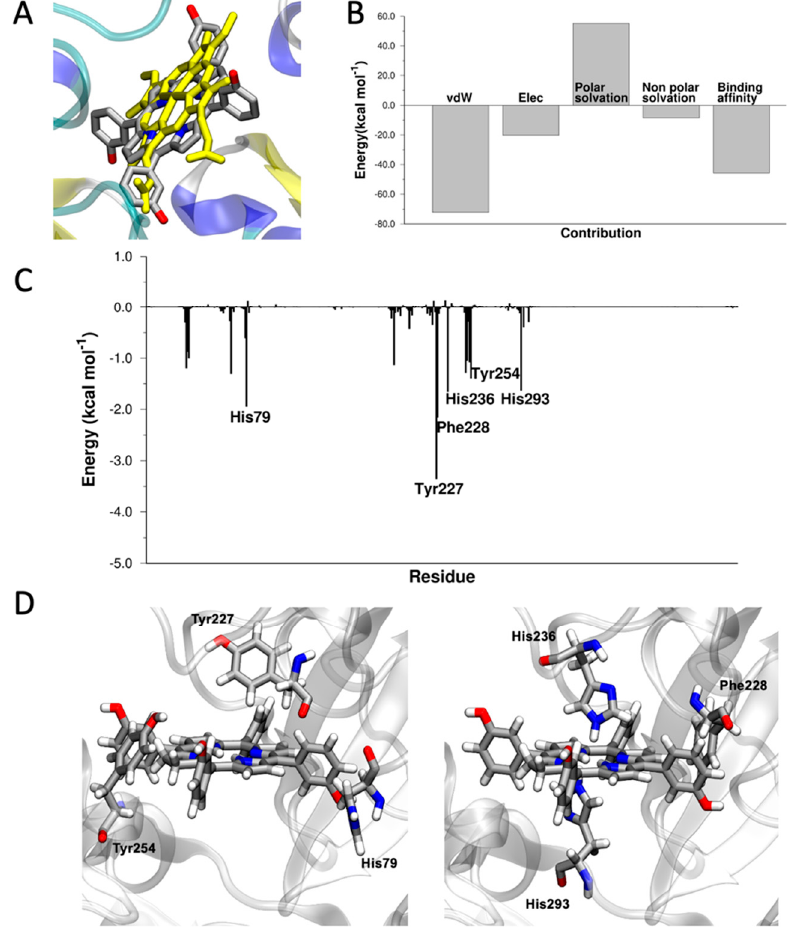
Figure 4. ( A ) Superposition of the crystallographic structure of heme (in yellow, PDB 1qjs) and docked structure of mTHPC in the heme-binding site of hemopexin. ( B ) Energy components of Δ E binding . ( C ) Δ E binding decomposed per residue. ( D ) Graphical representation of the interaction between His79, Tyr227, Phe228, His236, Tyr254, His293, and mTHPC. Images created with VMD